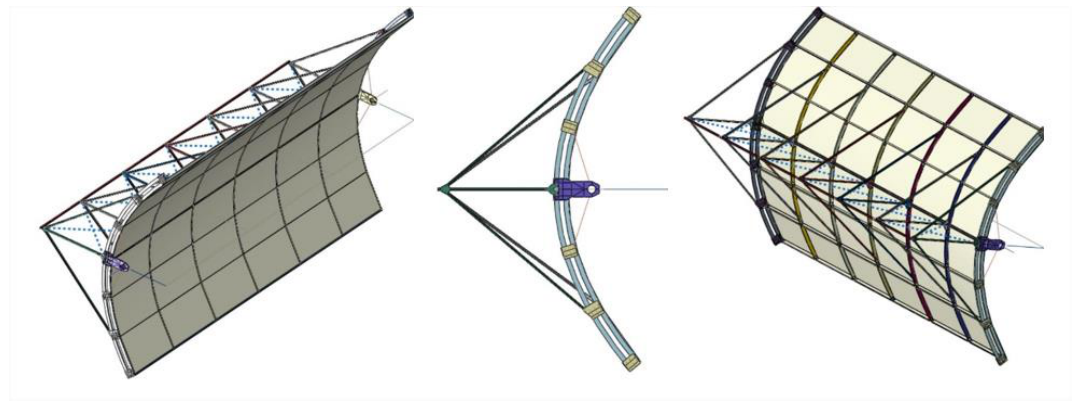
Figure 4. Assembly preview.